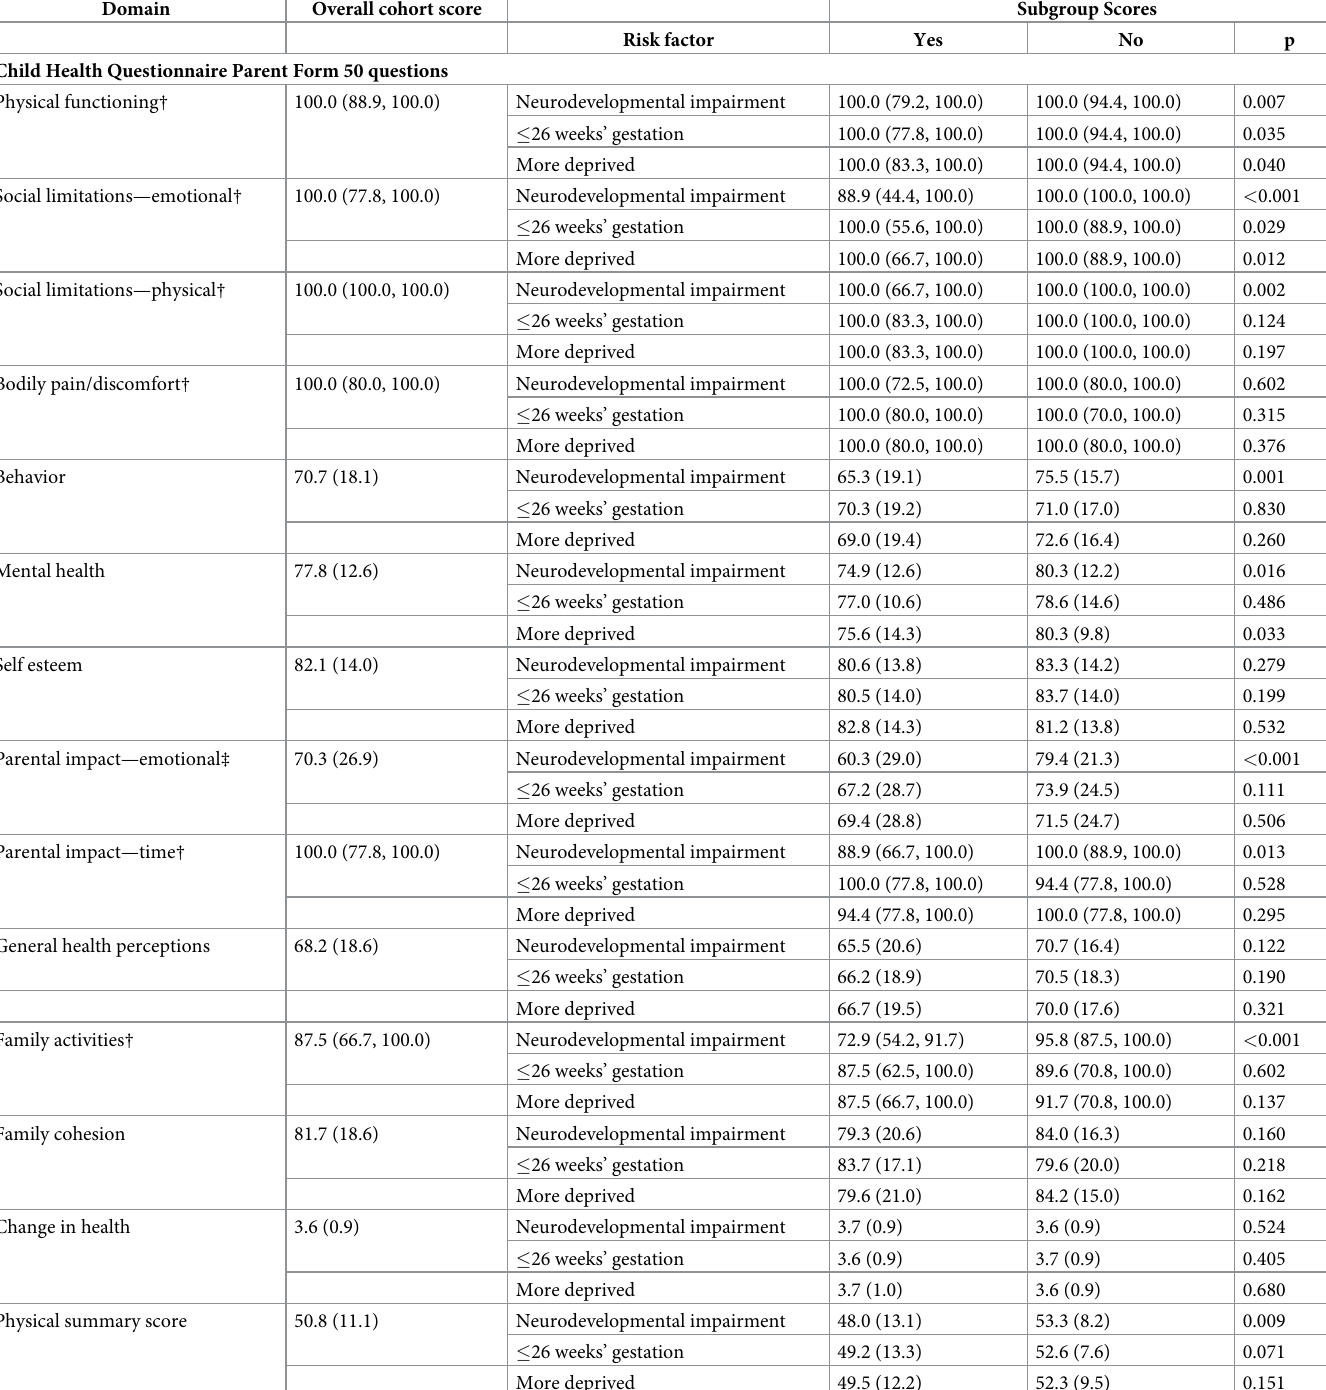
Table 2. Health-related quality of life scores for children with and without neurodevelopmental impairment, lower gestation, and greater socio-economic deprivation.